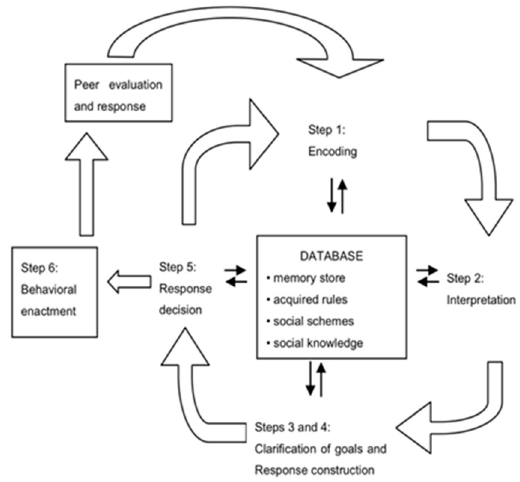
Figure 1. The social information processing model (based on Crick and Dodge, 1994).